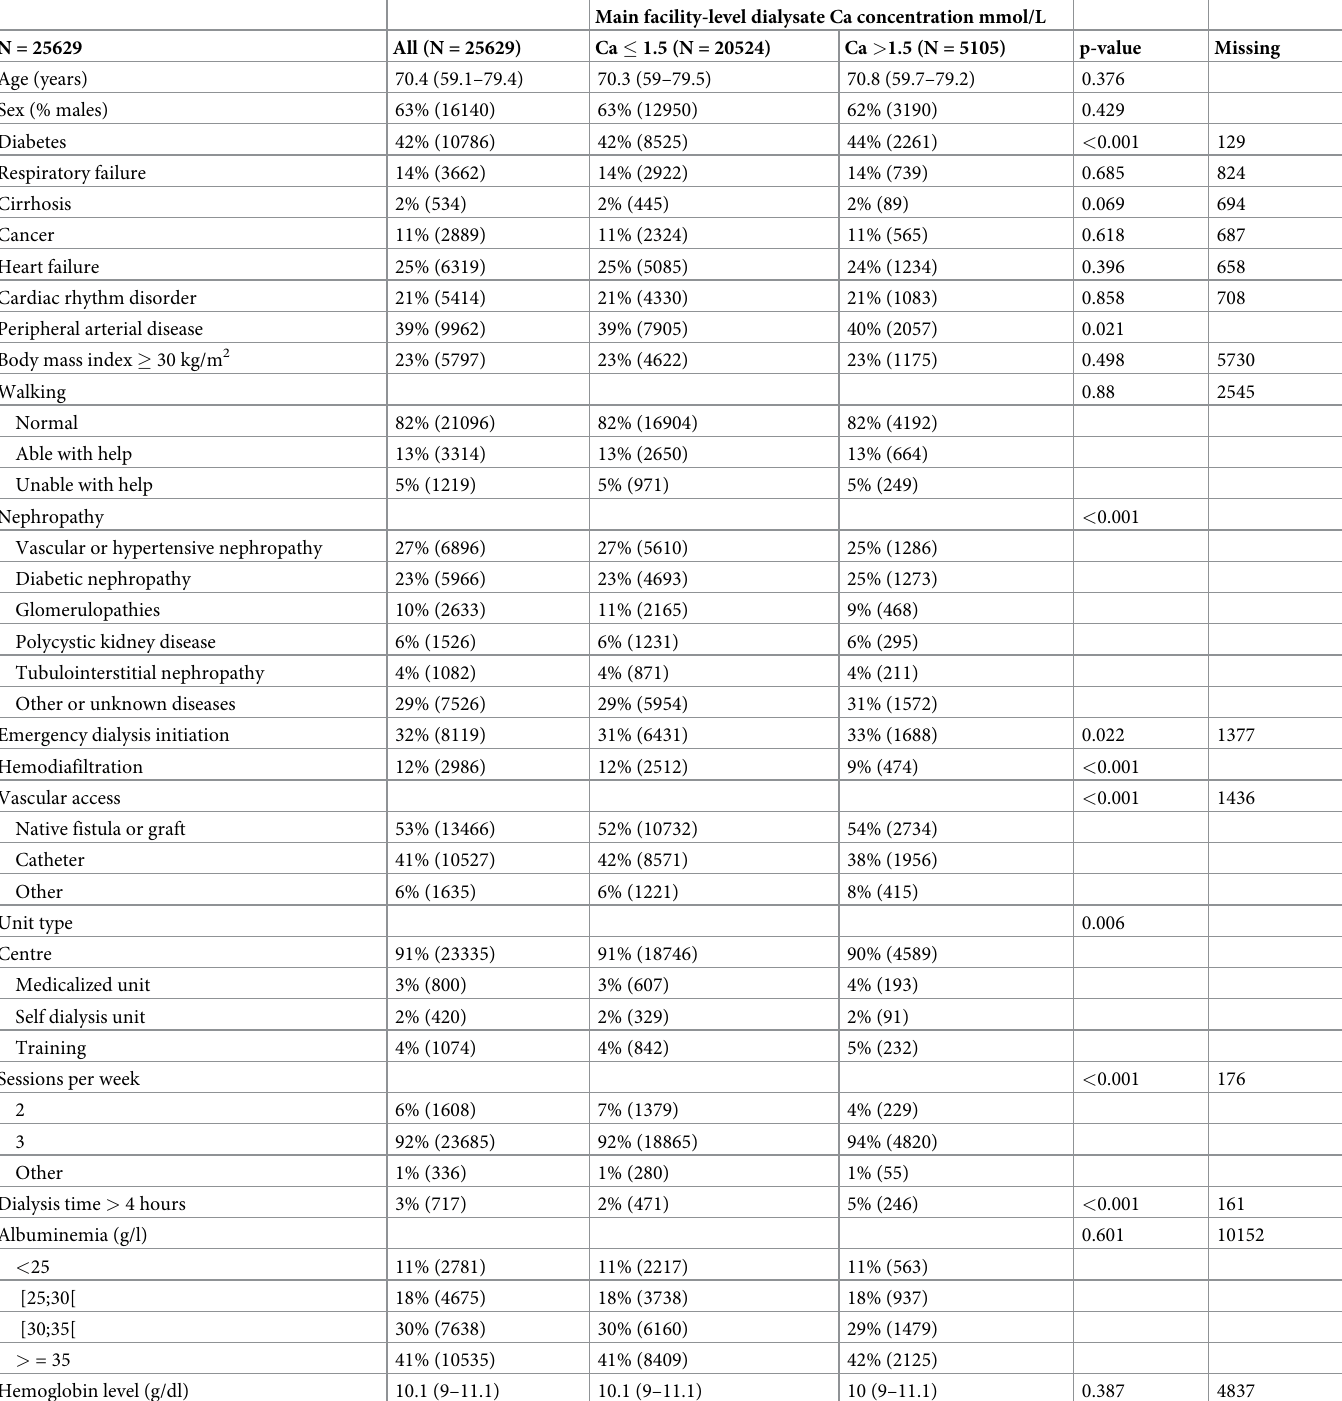
Table 3. Characteristics of the population at dialysis initiation, as extracted from the REIN registry after multiple imputations and as a function of the main dialy- sate calcium concentration used in the baseline